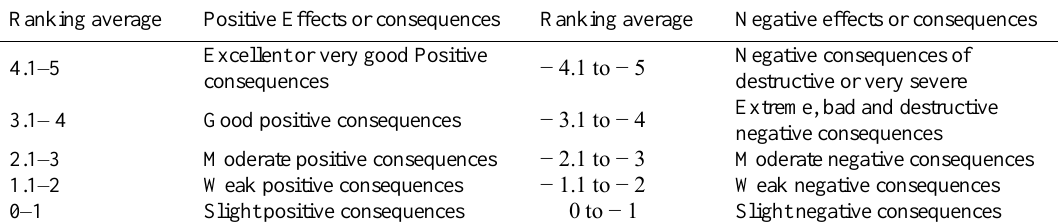
Table 6 . Classified of positive and negative effects in Iranian Leopold matrix (Gholmalifard et al.,